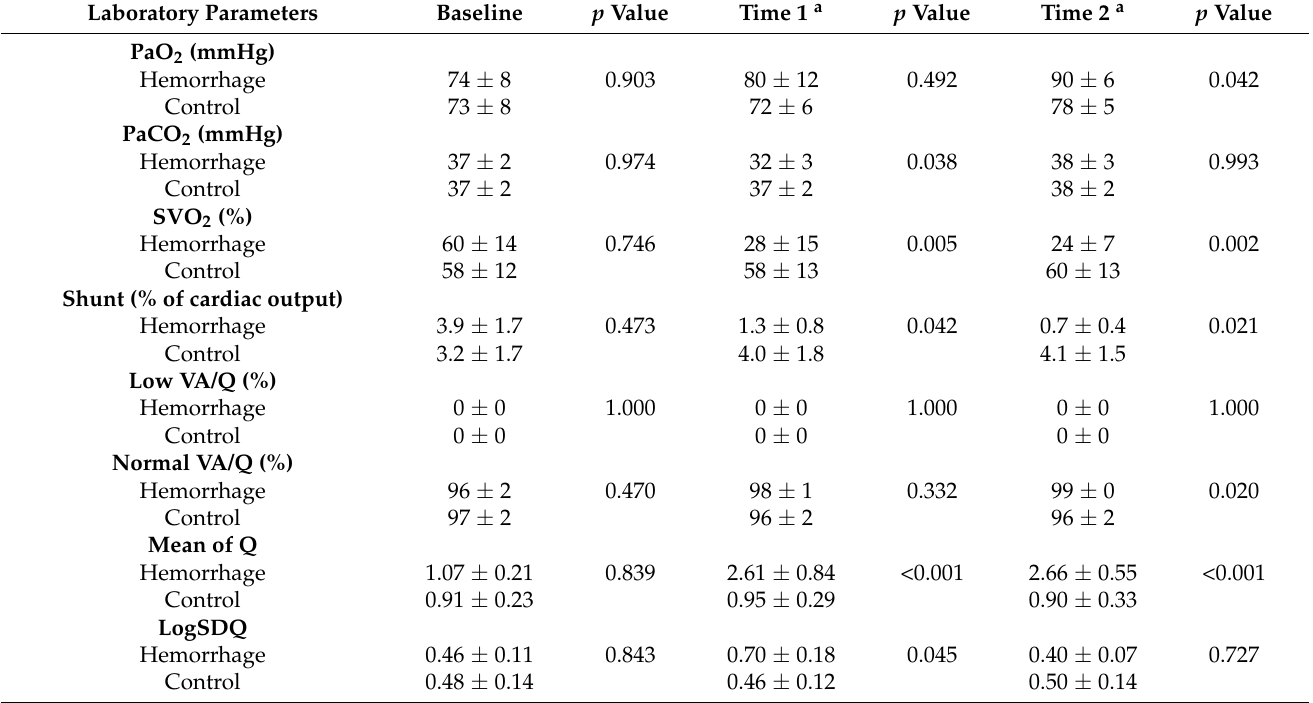
Table 3. Pulmonary gas exchange in acute hemorrhagic